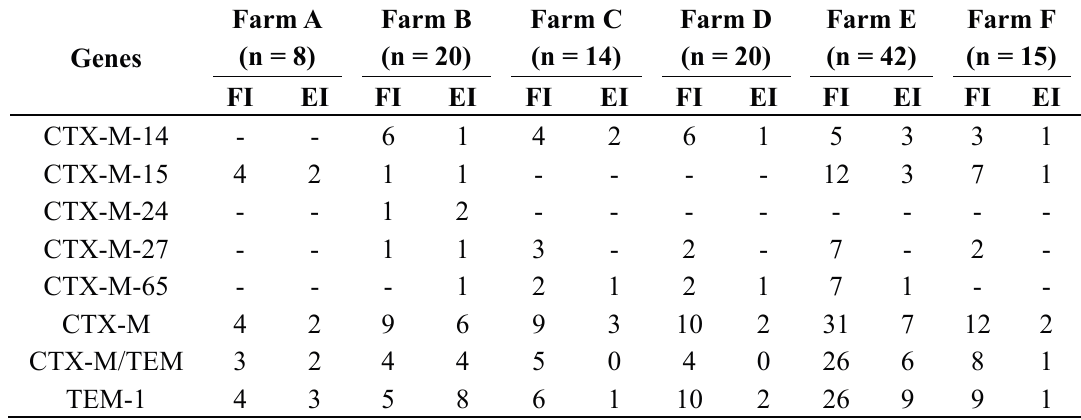
Table 4. β -Lactamase genes in the phenotypic detected ESBL-producing E. coli from fecal and environmental samples. Fecal isolates, FI; Environmental isolates,